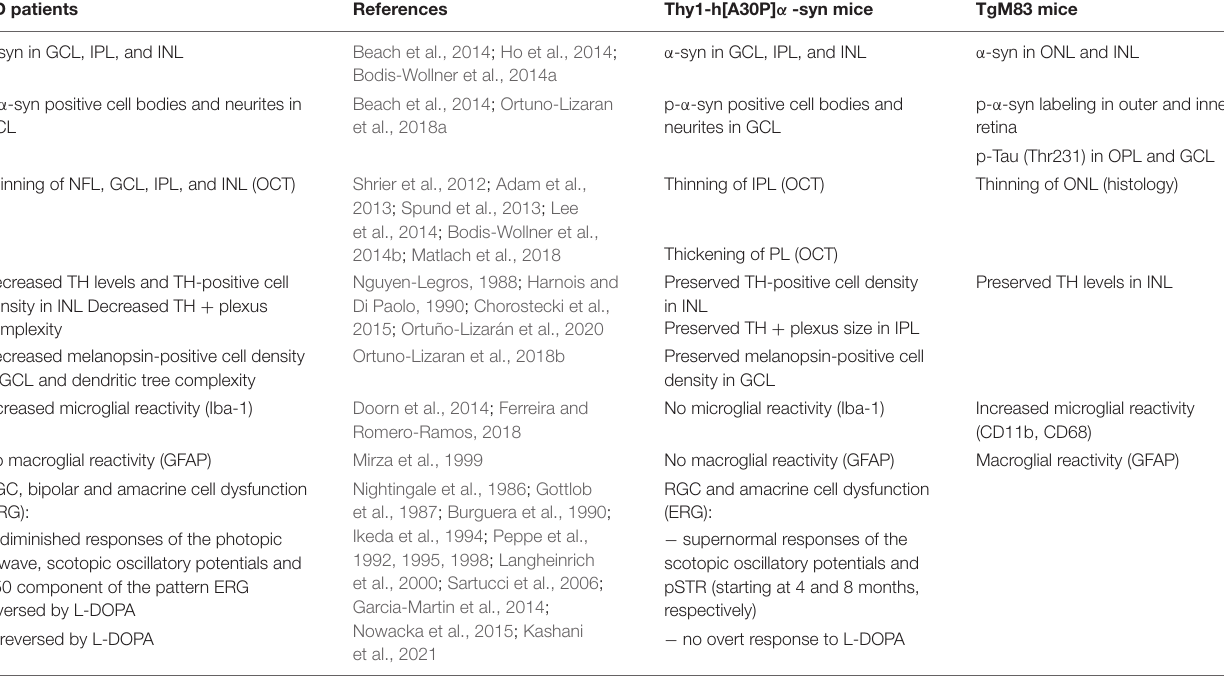
TABLE 1 | Summary of the phenotypical alterations observed in the retina of PD patients, Thy1-h[A30P] α -syn mice. PD